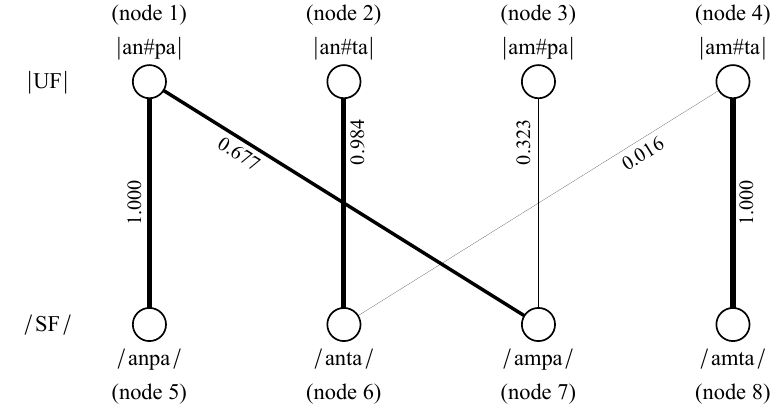
The average of instar